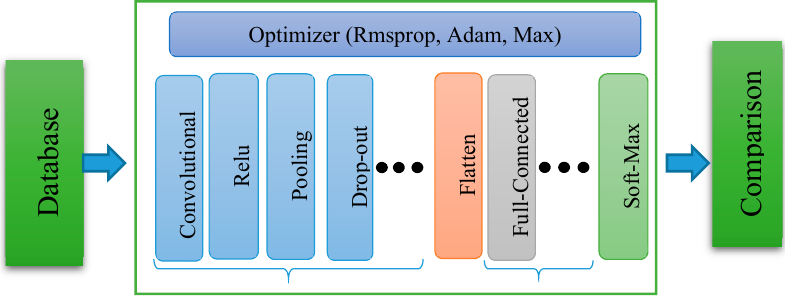
Figure 1. The schematic diagram of deep convolutional neural network (DCNN) architecture.